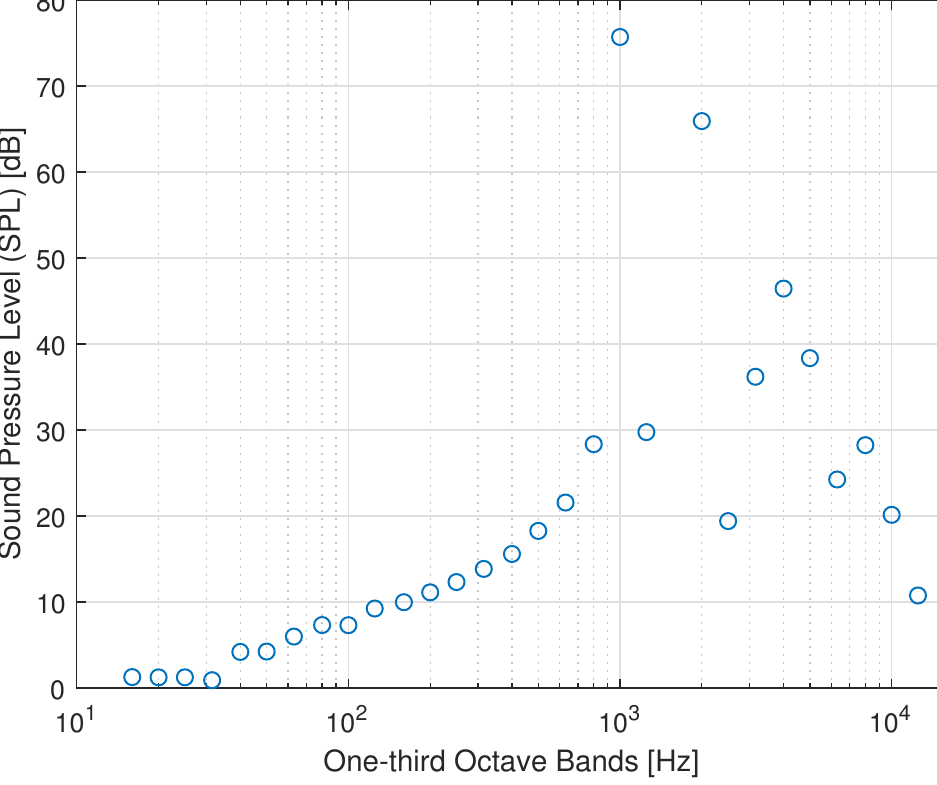
Figure 19. Trailing-edge flap total noise one-third octave bands at azimuthal angle of 90 ◦